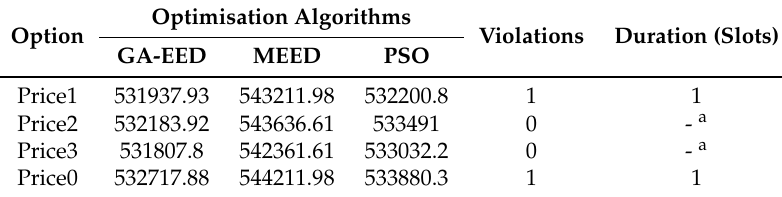
Figure 13. Price3 pipeline pressure profile at tapoff-point. Table 6. Supply cost (US$) for various optimisation